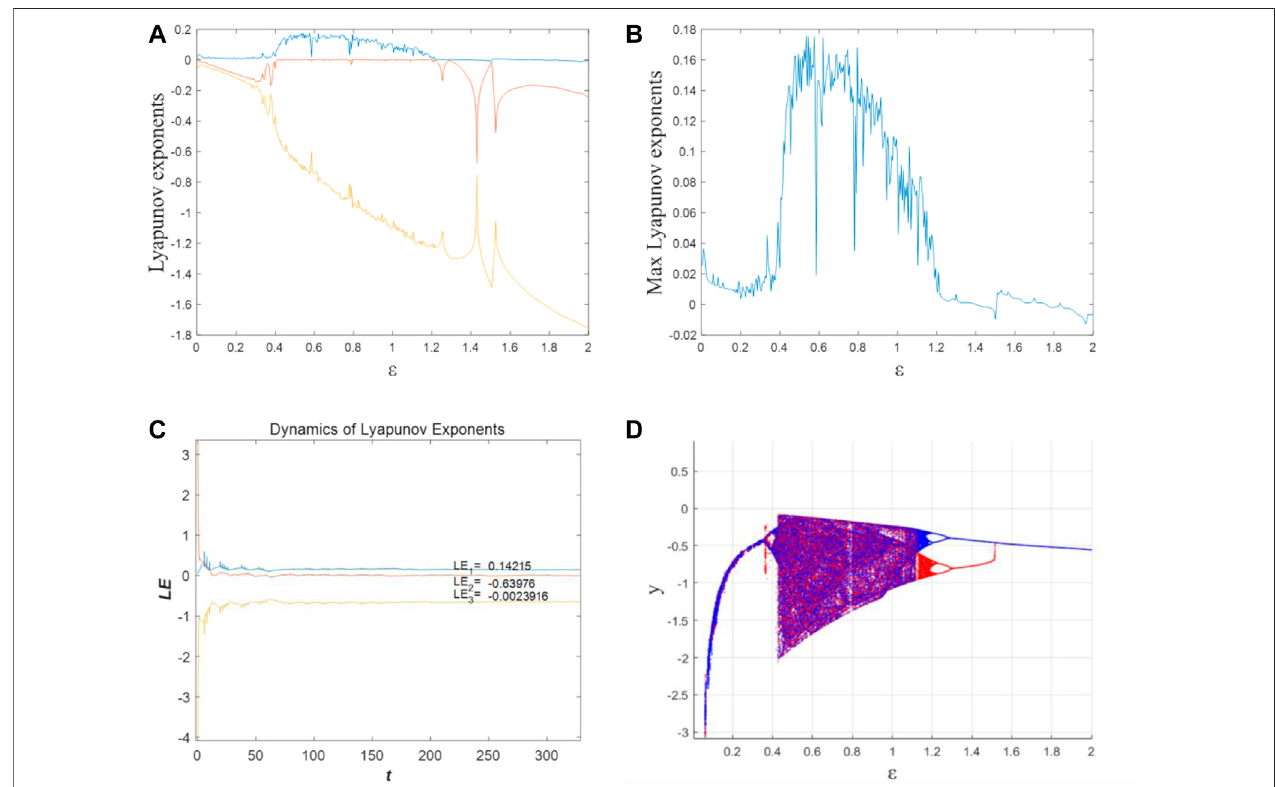
FIGURE 3 | Lyapunov exponent spectrum and bifurcation diagram at different initial values. (A) Lyapunov exponents at ( x 0 , y 0 , z 0 ) = (0, 0.4, 0). (B) Max Lyapunov exponentat( x 0 , y 0 , z 0 )=(0,0.4,0). (C) LEswhen ε =0.5at( x 0 , y 0 , z 0 )=(0,0.4,0). (D) Bifurcationdiagramat( x 0 , y 0 , z 0 )=(0,0.4,0)(red)and( x 0 , y 0 , z 0 )=(0, −